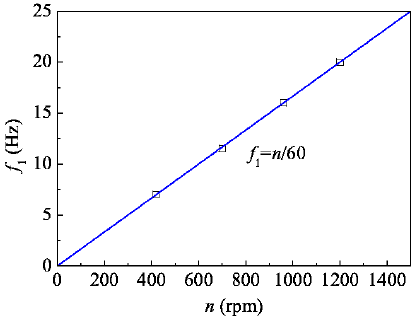
Figure 8. 1-order frequency of vibration signal versus rotating speed.